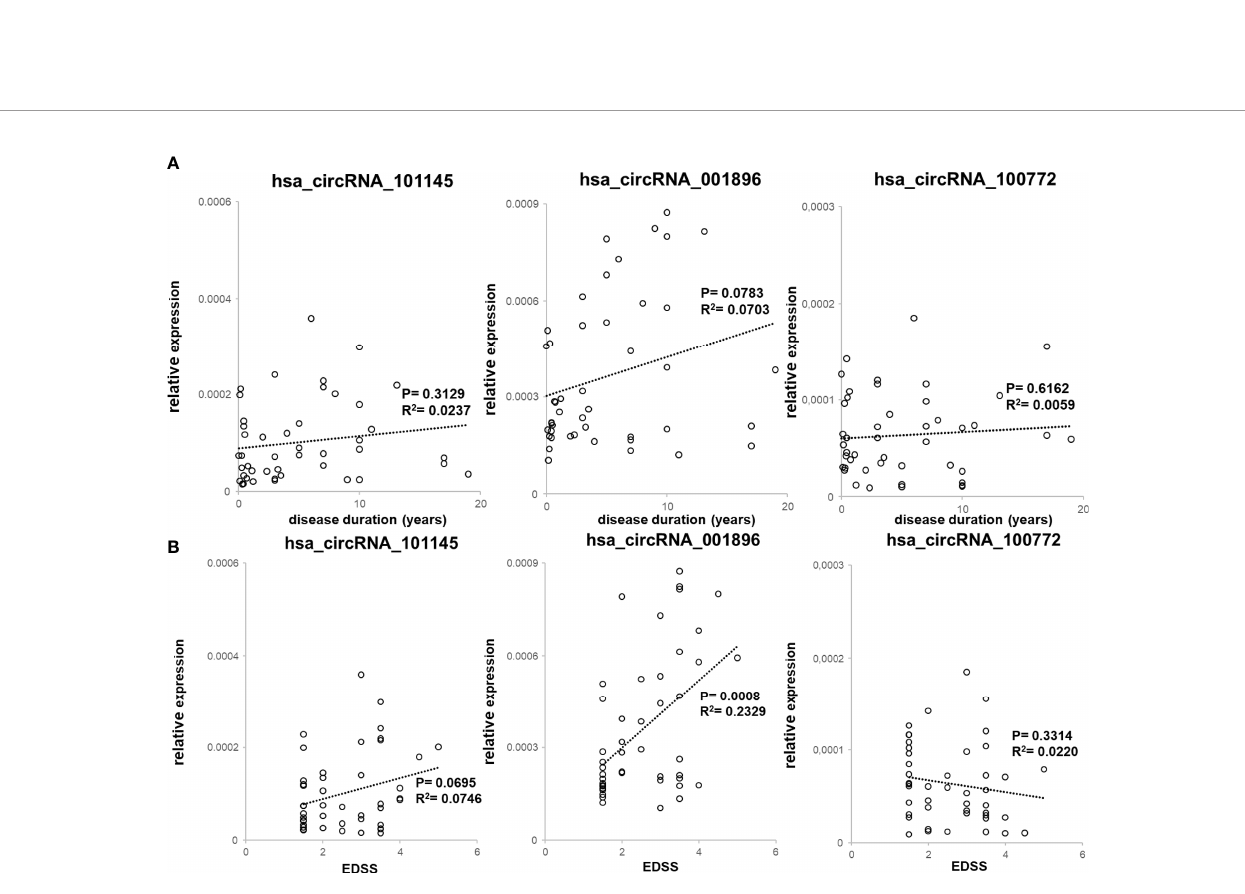
FIGURE 4 | Correlation between downregulated circRNA levels with clinical RRMS parameters. (A) PBMC hsa_circRNA_101145, hsa_circRNA_001896, and hsa_circRNA_100772 expression levels were plotted against disease duration. Circles represent individual data, and the line represents a correlation trend; P -values were calculated by R 2 statistic. (B) PBMC hsa_circRNA_101145, hsa_circRNA_001896, and hsa_circRNA_100772 expression levels were plotted against EDSS. Circles represent individual data, and the line represents a correlation trend; P -values were calculated by R 2 statistics.